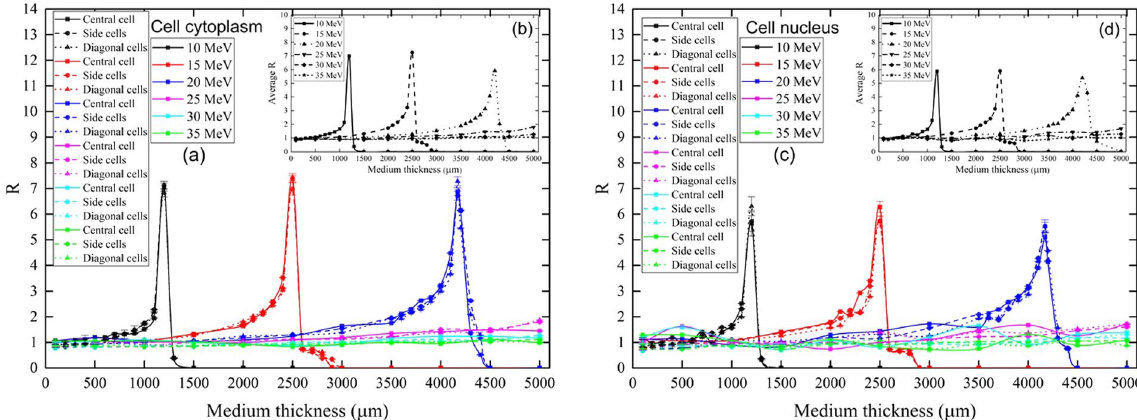
Figure 4. Variations of ( a ) calibration coefficient R and ( b ) average R with medium thickness in the cell cytoplasm, and variations of ( c ) R and ( d ) average R with medium thickness in the cell nucleus, for different incident proton energies. (The lines connecting the points do not represent data and are only presented to help the eye). (Note: error bars are smaller than the symbols).